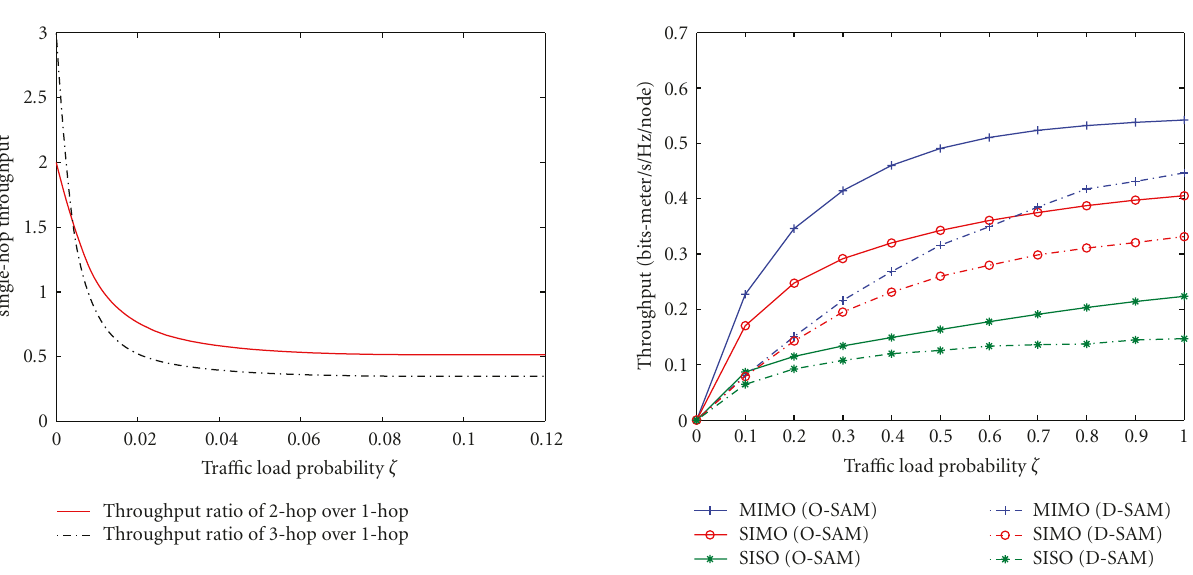
Figure 9: Throughput of O-SAM and D-SAM for SISO, SIMO, and MIMO channels. We used ρ = 1, SNR = 40dB, and square topology.